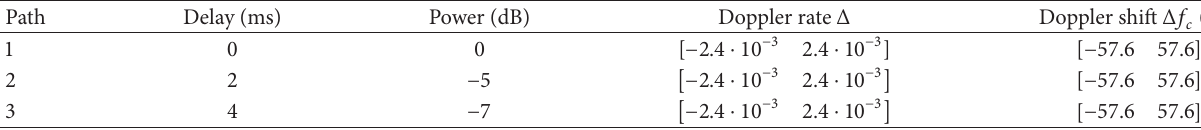
Table 2: Channel for simulation (CNR = 35 dB).